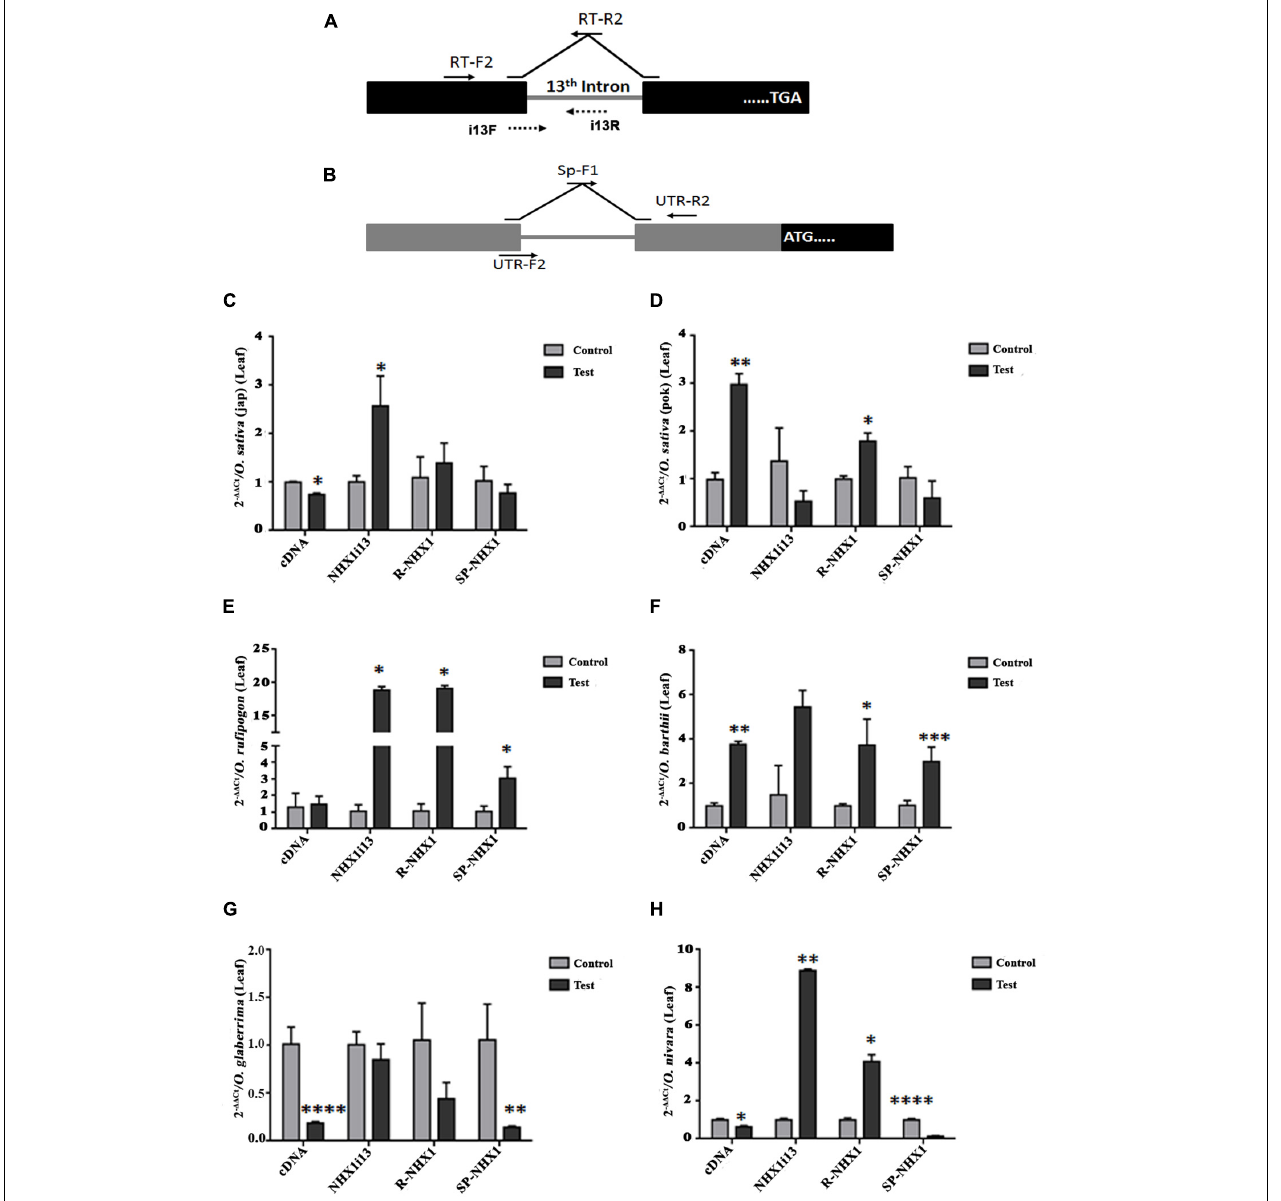
FIGURE 7 | qRT-PCR expression analysis of NHX1 splice variants in Oryza spp. leaf tissues under salinity. The following splice variants were examined: correctly spliced transcript (cDNA), 13th intron retaining transcript (NHXi13), the 5 (cid:48) UTR intron retaining NHX1 transcript (R-NHX1) and the 5 (cid:48) UTR intron splicing NHX1 transcript (Sp-NHX1). (A) For the correctly spliced NHX1 transcript 12th exon forward primer (RT-F2) and 13th–12th exon reverse (RT-R2) primers were used (Kizhakkedath et al., 2015). For the 13th intron retention transcript i13F (12th exon-13th intron junction) and i13R (13th intron) primers were used. (B) For the 5 (cid:48) UTR intron retaining/splicing transcripts primer pairs (UTR-F2 and UTR-R2; Sp-F1 and UTR-R2 respectively) were use ( Supplementary Table S2 ). (C–H) Oryza spp. examined: O. sativa [ssp. japonica (C) ] , O. sativa [ssp. indica cv. Pokkali (D) ] , O. rufipogon (E) , O. barthii (F) , O. glaberrima (G) , O. nivara (H) . All qRT-PCRs for